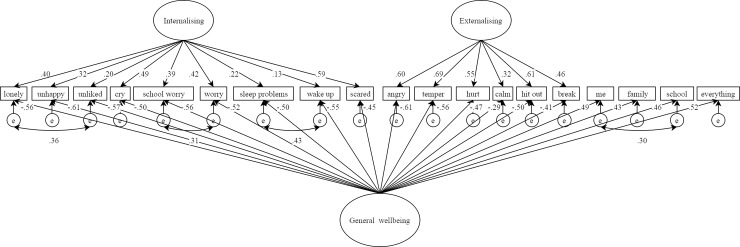
S-1wellbeing model results.